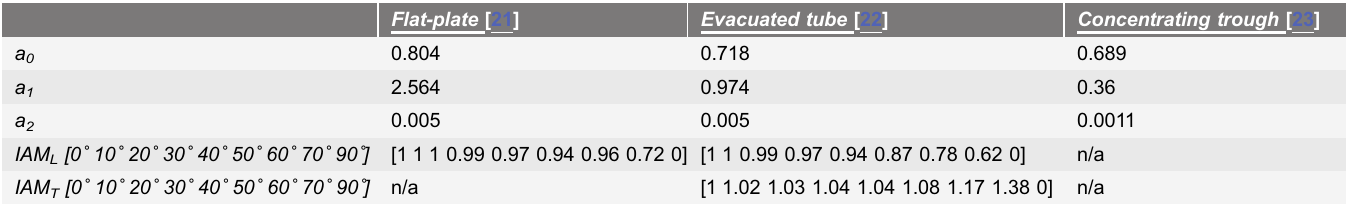
Table 2. Thermal collector coefficients.